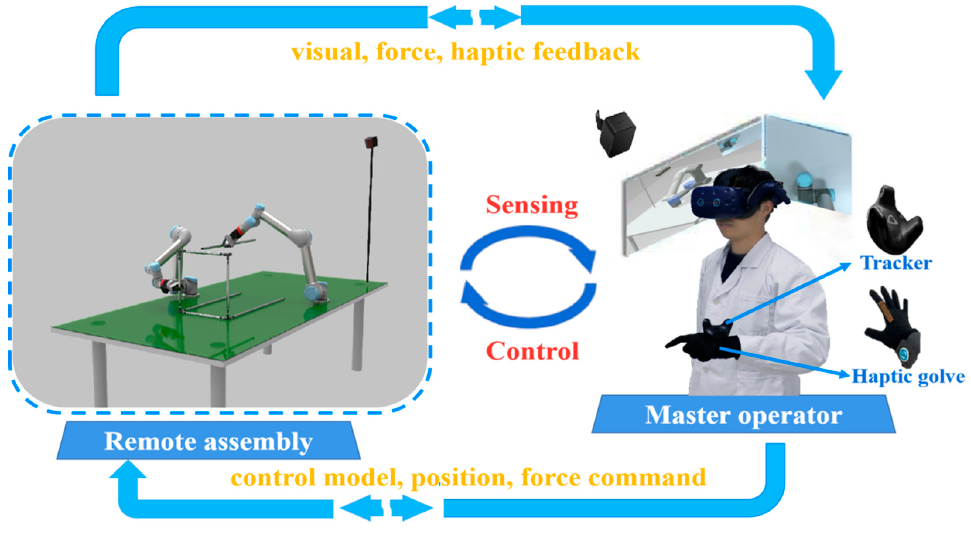
Figure 1. System of teleoperation